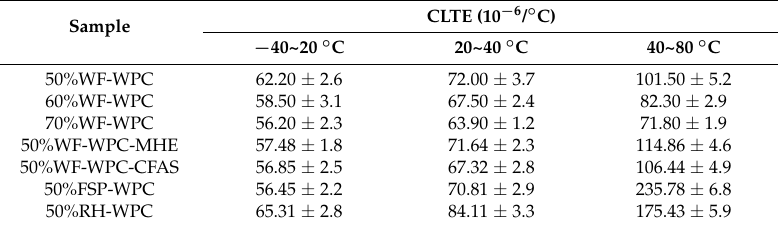
Table 5. The coefficients of linear thermal expansion (CLTEs) of WPCs at different temperatures.